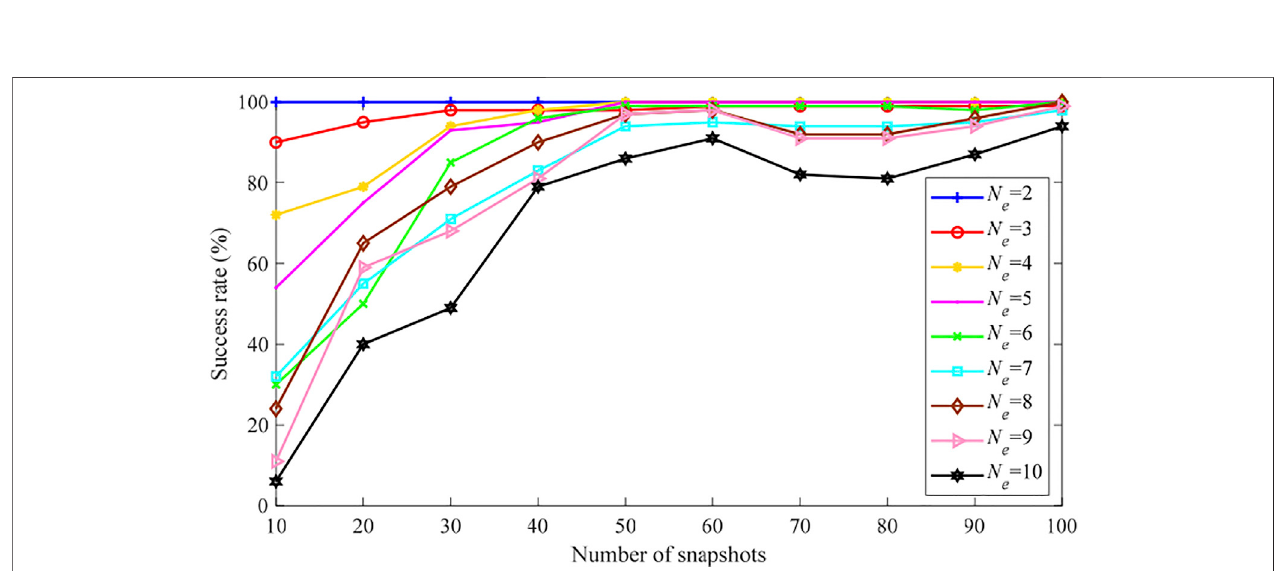
FIGURE 11 | PEI success rate of the IEEE 118-bus system (Case 4, 2